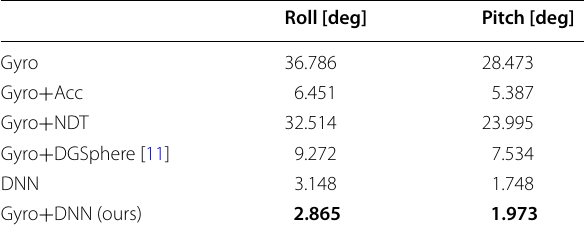
Table 6 MAE of dynamic estimation in simulator